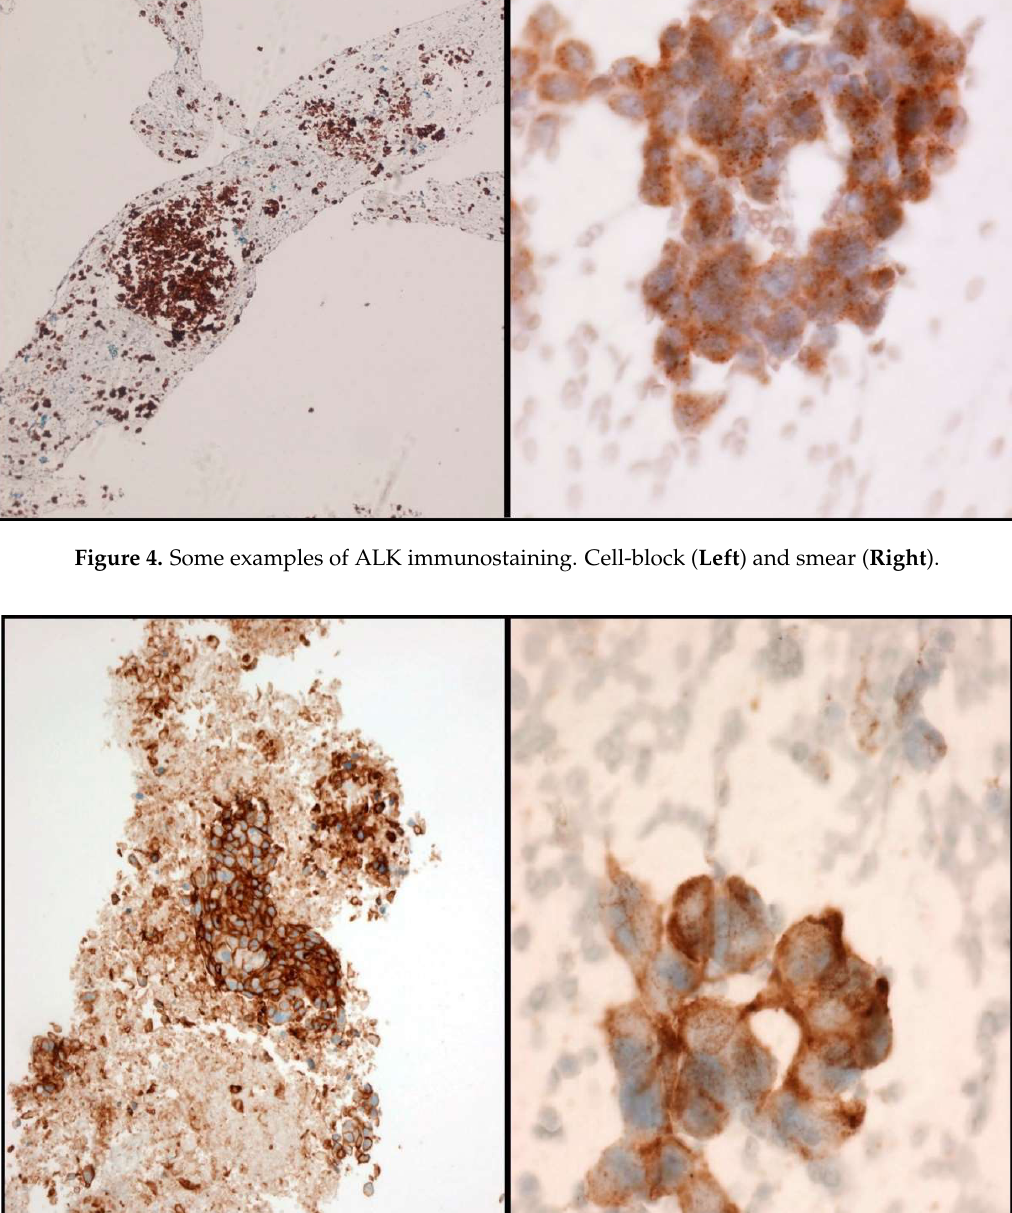
Figure 6. Controls used for PD-L1: formalin-fixed and paraffin-embedded (FFPE) Placenta tissue ( Left ) and smears ( Right ).